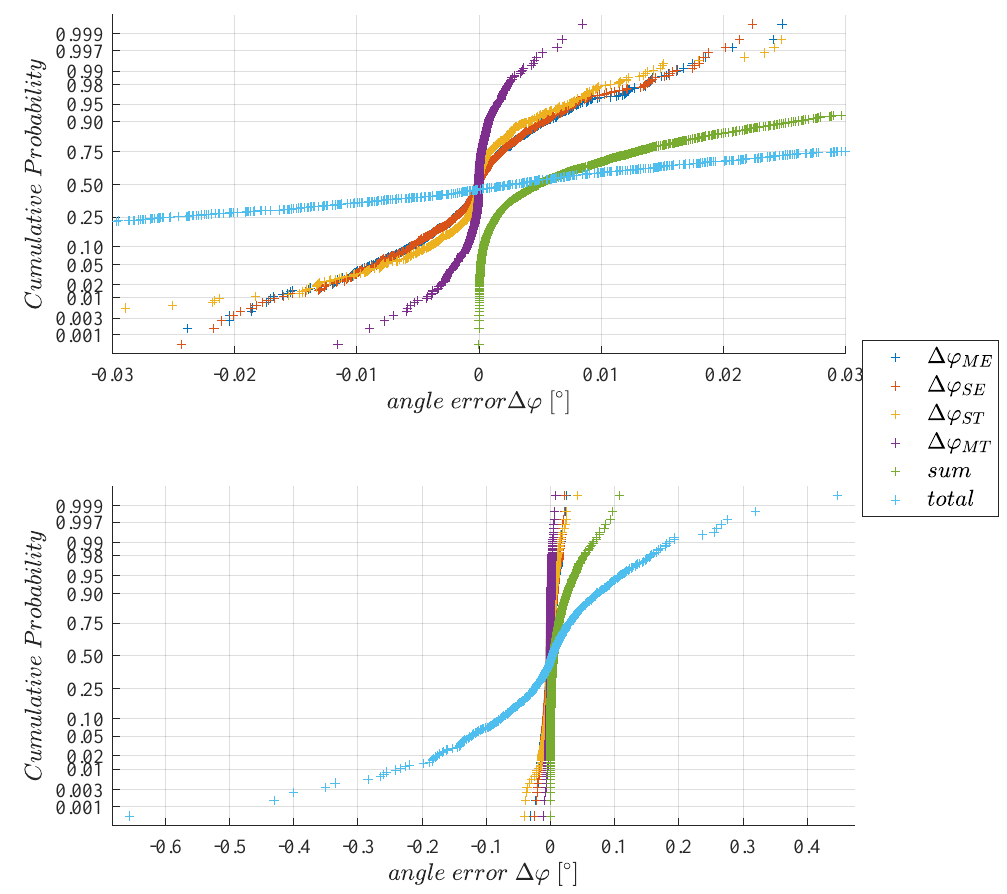
Figure 5. Cumulative probability distribution of angle errors for assembly tolerances of Table 2. ∆ ϕ ME = angle error for magnet eccentricity only, only, ∆ ϕ MT for magnet tilt only, sum = | ∆ ϕ ME | + | ∆ ϕ SE | + | ∆ ϕ ST | + | ∆ ϕ MT | , and total = real angle error if all assembly tolerances of Table 2 are simultaneously present; 1000 Monte Carlo runs conducted.